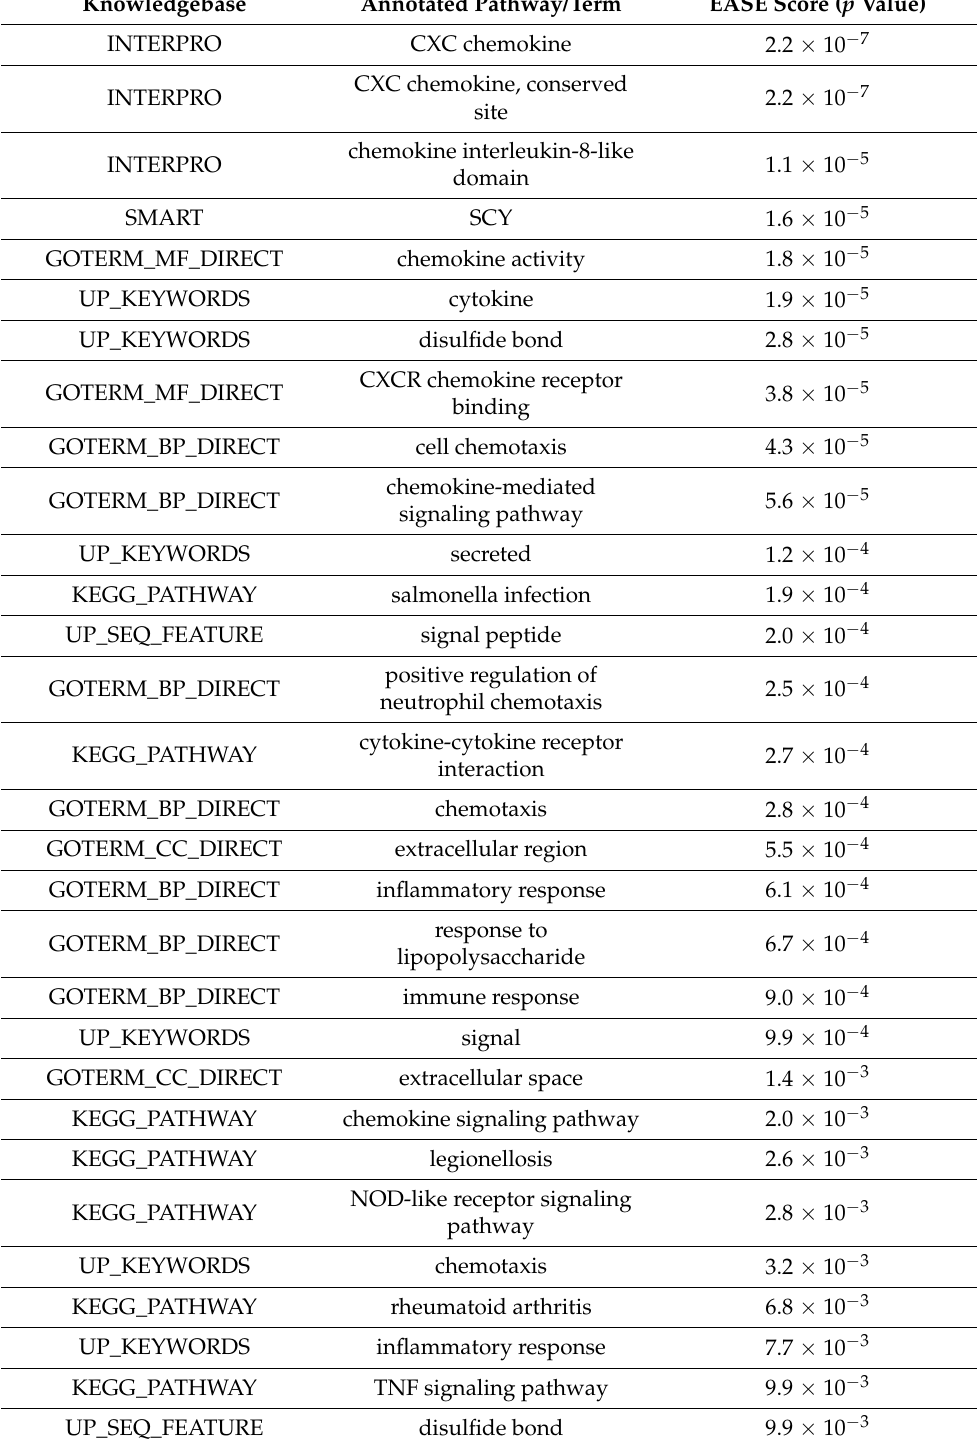
Table 3. Clustering of annotated pathways (enrichment score